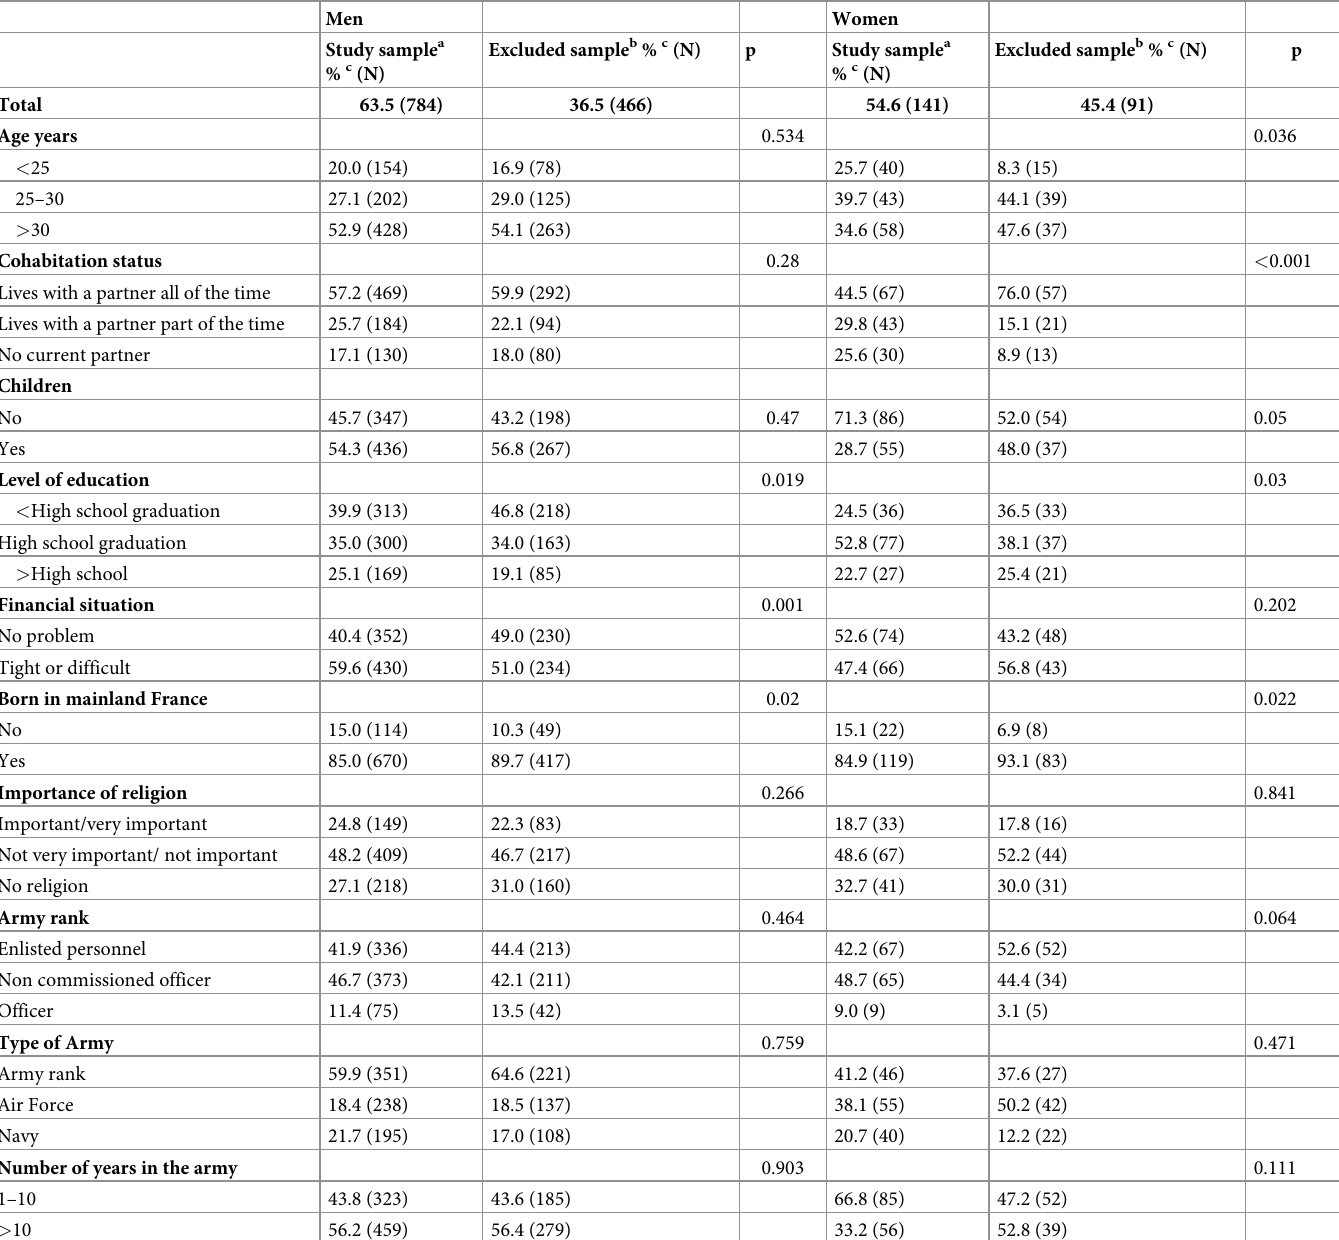
Table 1. Sociodemographic characteristics of the study sample (n = 925) and of respondents excluded from the analysis (n = 557), COSEMIL